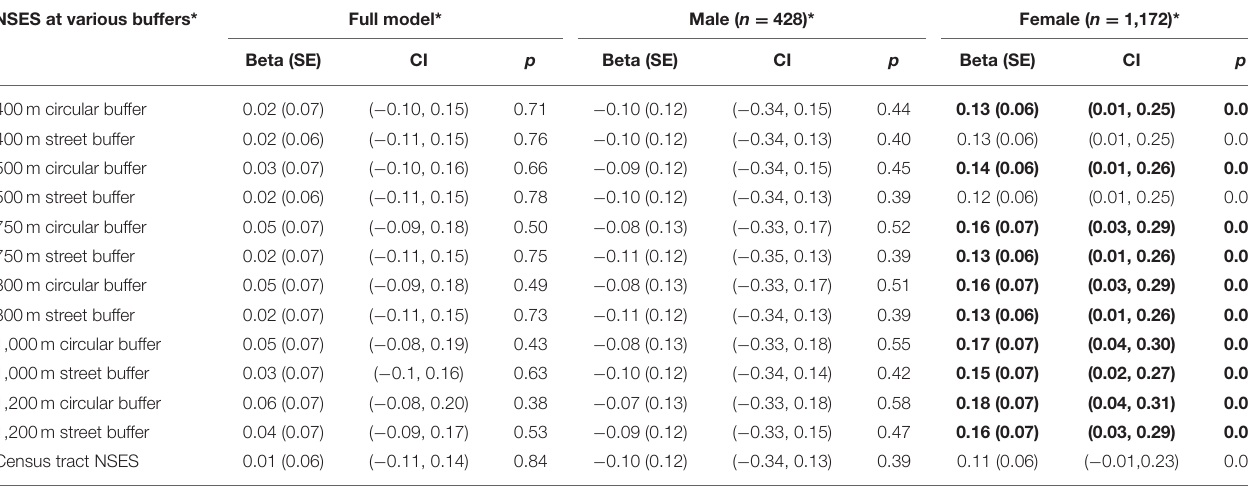
* Models control for individual level age, race/ethnicity, gender, educational attainment and urbanicity; bolded values are significant at p < 0.05; dependent variable is estimated daily frequency of consuming fruits, salad, and other vegetables. NSES, Neighborhood socioeconomic